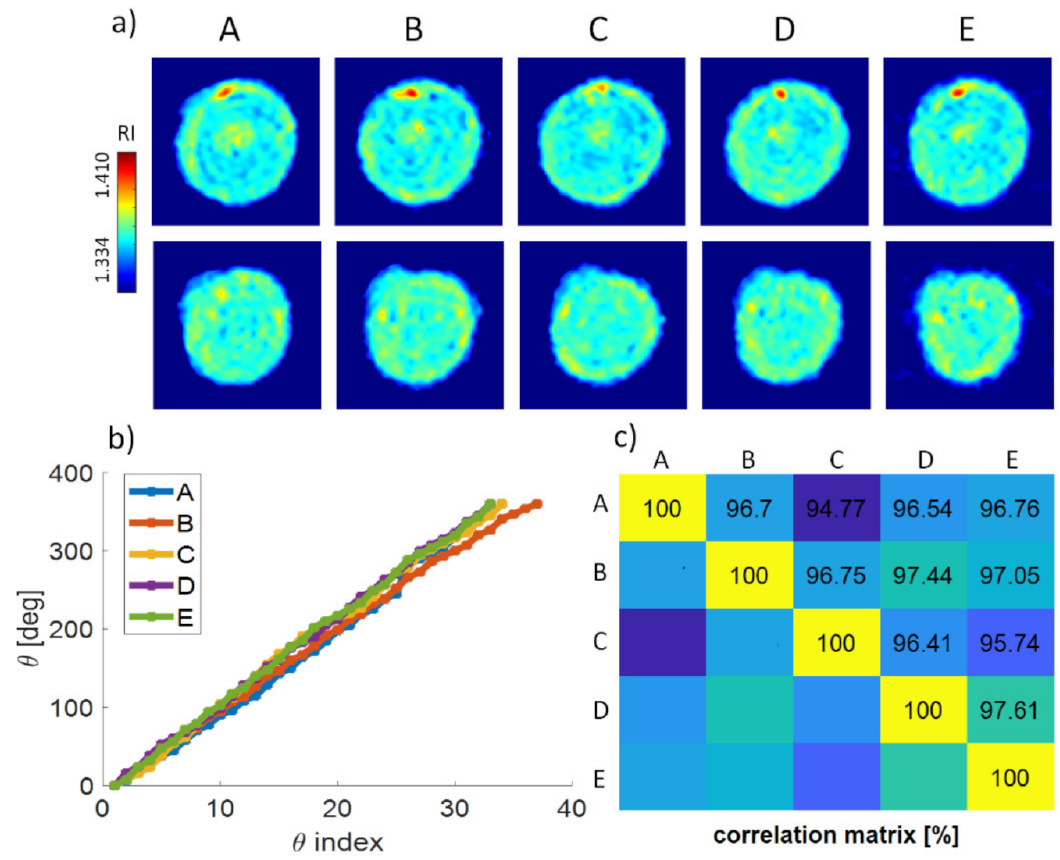
Figure 8. ( a – c ) Repeatability of the experimental reconstruction process. ( a ) Comparison between reconstructions of the same tomograms for five different observations of the same cell [A–E] which is rotated five times through the channel: central (top row) and peripheral (bottom row) x-z slices of the tomograms obtained by HOTV-2; ( b ) retrieved angular sequences for the five considered experiments; ( c ) correlation matrix calculated between the tomograms reconstructed for the five considered independent